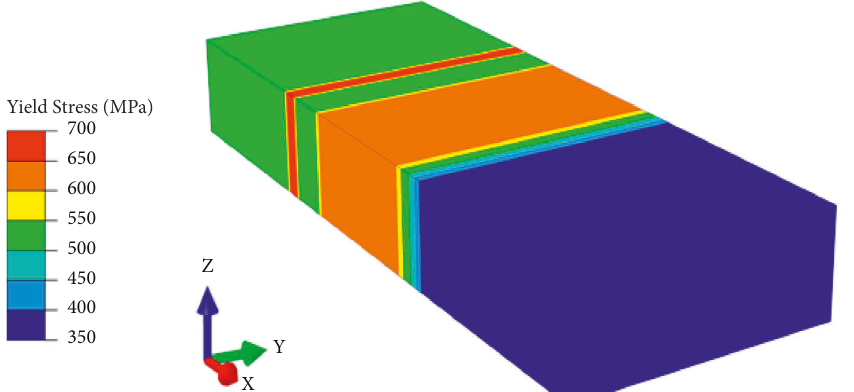
Figure 6: Yield strength contour distribution in the dual-field model.